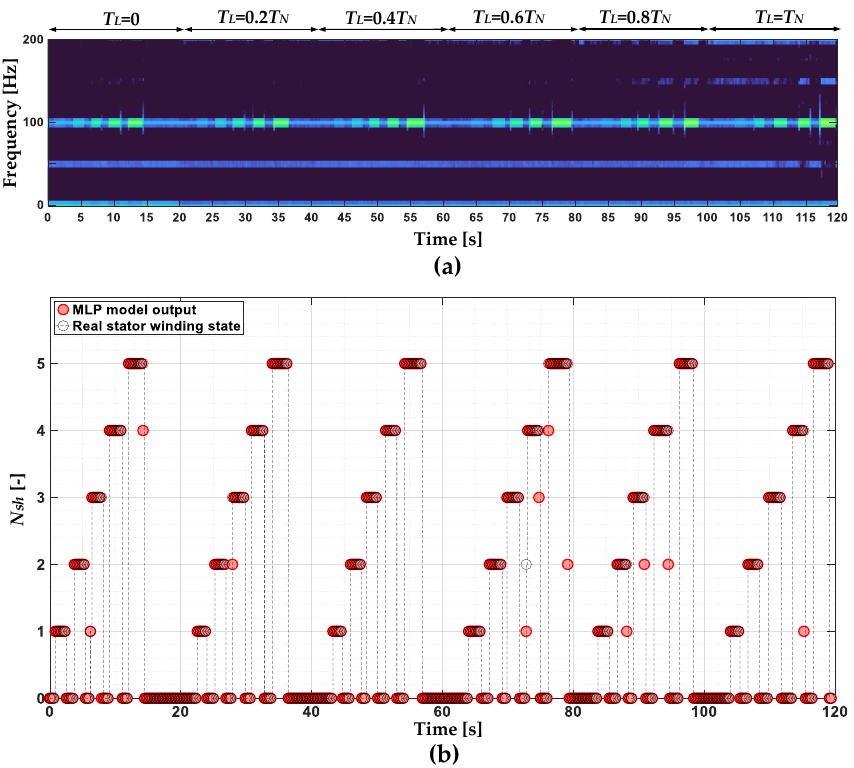
Figure 26. ( a ) Part of the stator phase current negative sequence component STFT spectrogram and ( b ) response of the MLP-based ITSC fault classifier.